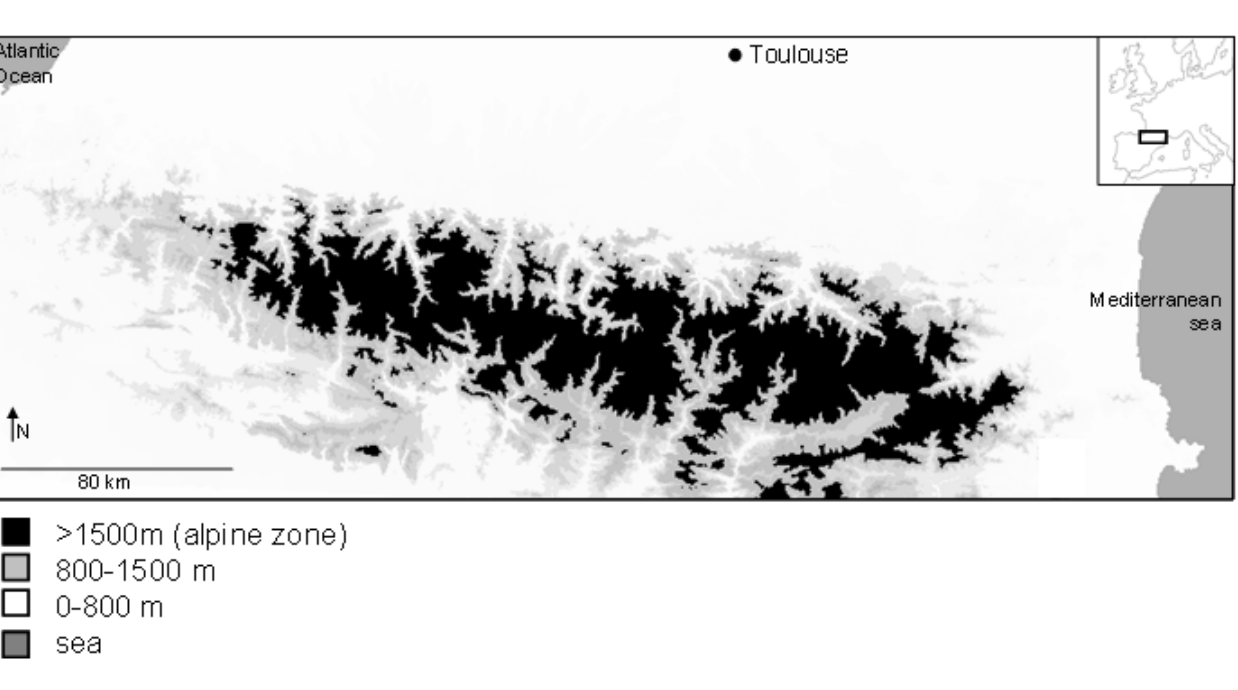
Fig. 1. Map of the Pyrenees massif showing the alpine zone